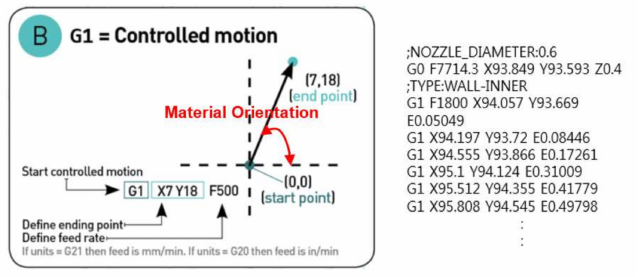
Figure 16. Determination of material